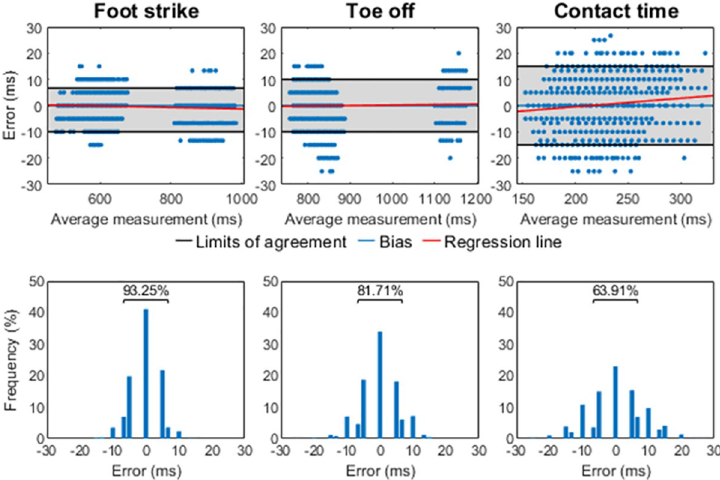
Fig 5. Algorithm performance for foot-strike, toe-off and contact time. Top row: Bland-Altman plots. The top and bottom border of the grey patch represent the 95% limits of agreement. Regression lines are included to aid visual interpretation. Correlations between instant within the gait cycle and error were trivial for foot-strike (r = -0.07, p < 0.001) and toe-off (r = 0.04, p < 0.001) hence, line coefficients and coefficient of determination are not reported. Average contact time length and error in contact time (r = 0.1, p < 0.001) line coefficients and coefficient of determination are reported in the Results section. Second row: error histograms. The frequency of errors contained within ± 1 motion capture frame of the ground truth event is